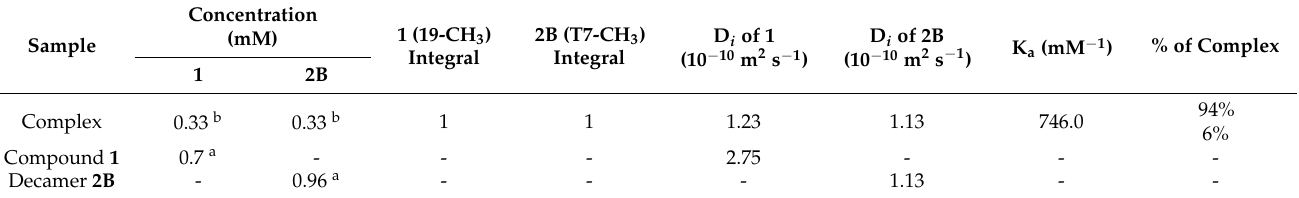
Table 9. The diffusion constants Di × 10 − 10 (m 2 s − 1 ) and binding constant calculation of a complex 1 + 2B from DOSY